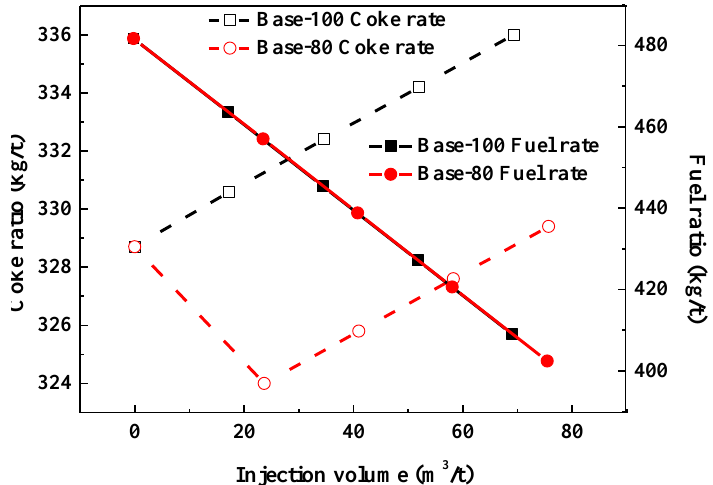
Figure 8. Coke ratio and fuel ratio of the blast furnace under different suitable gas injection volumes.